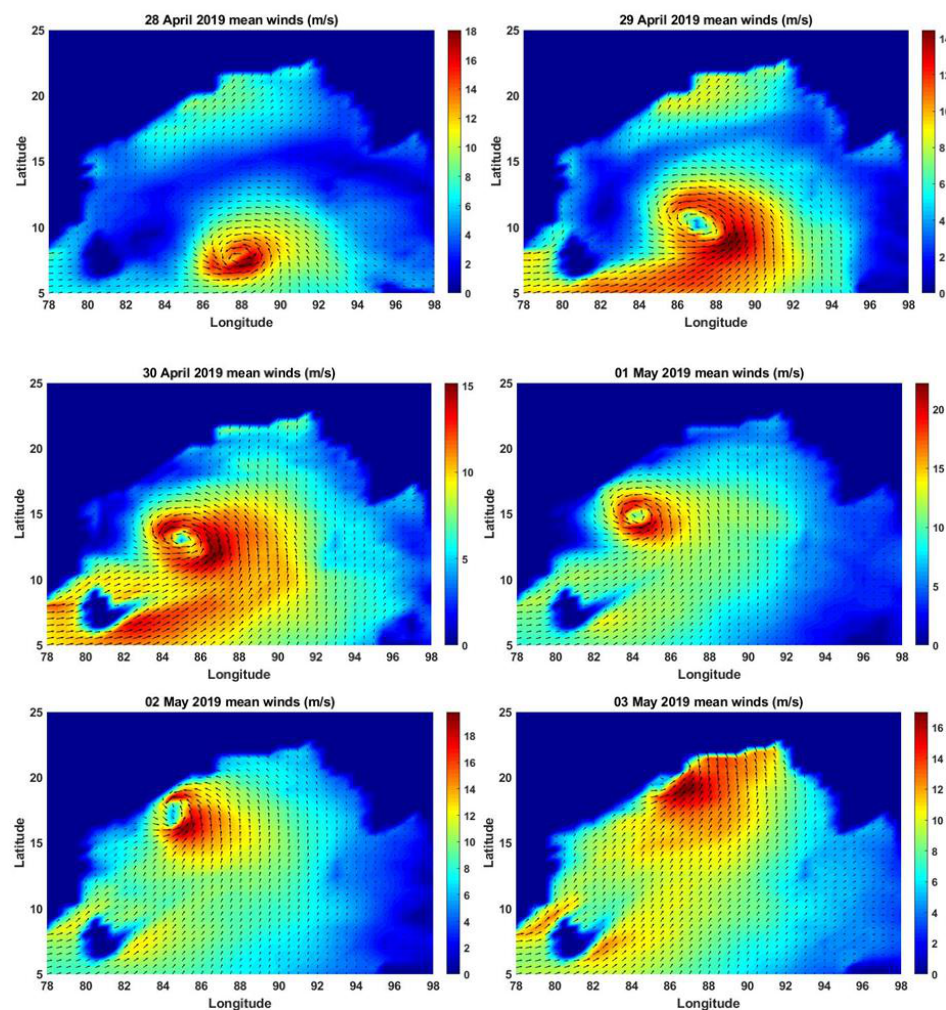
Figure 10. Mean winds (m/s) during FANI cyclone (28 April to 3 May 2019) from SCATSAT − 1 (25 km) daily products.